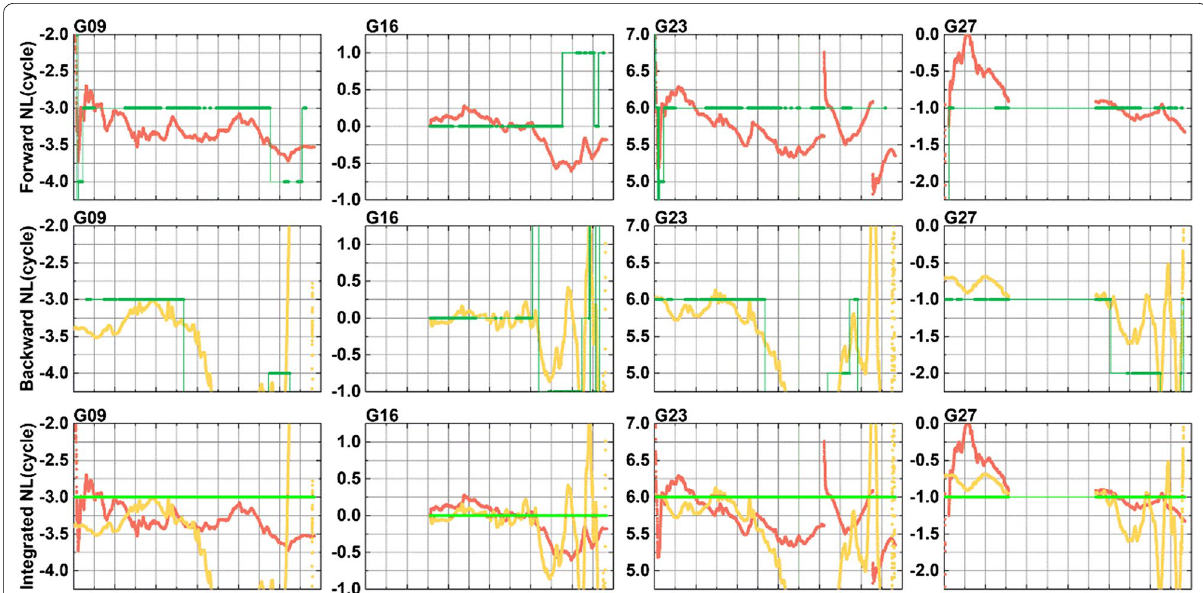
Fig. 5 NL resolution from the forward filter (top) and backward filter (middle) for G09, G16, G23 and G27. Red and yellow curve denote the ambiguity-float results in the forward filter and backward filter, respectively. The green curve is the respective ambiguity-fixed resolution. The bottom figures show the results of integration for G09, G16, G23, and G27. The light green curve denotes the integrated ambiguity. The range of x -axis is 3